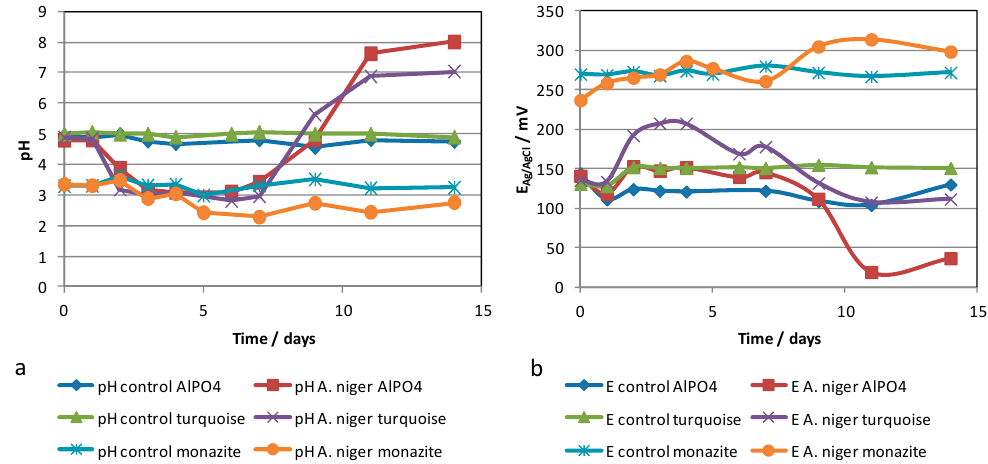
Figure 2. Evolution of ( a ) pH and ( b ) E Ag/AgCl in abiotic and biotic ( A. niger ) tests for different mineral phosphates (aluminum phosphate, turquoise, and monazite) at 1 g/L.